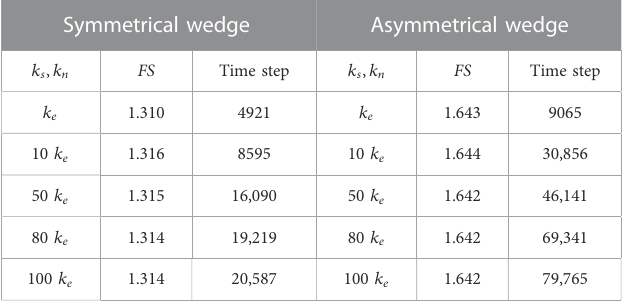
TABLE 5 Effects of k s ,k n on the FS and computation time for wedges. Symmetrical wedge